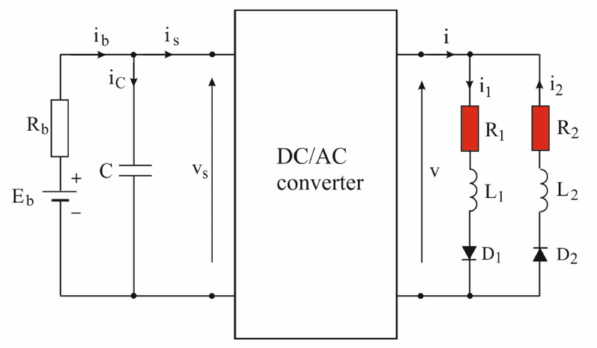
Figure 7. Circuit diagram of the motor supplied from the battery through the power inverter.